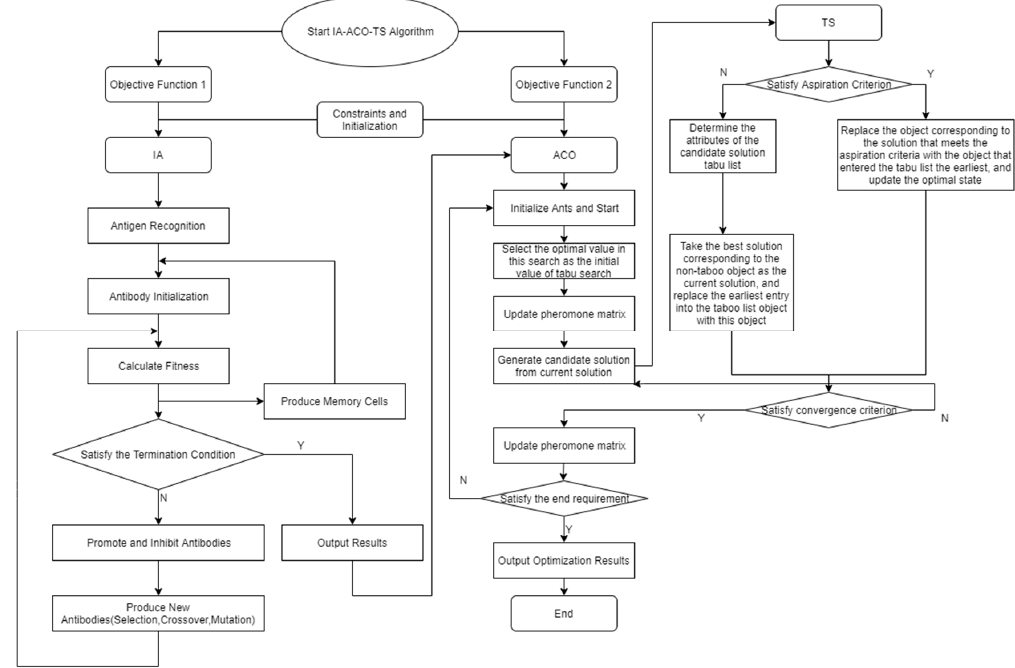
Figure 2. An illustration of the immune algorithm–ant colony optimization–tabu search (IA-ACO-TS) process.